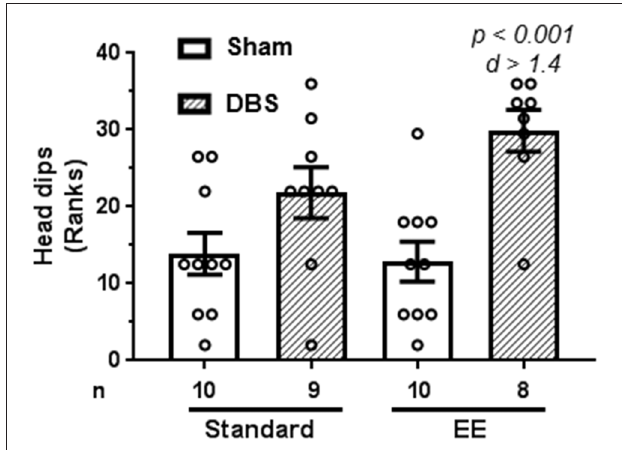
FIGURE 3 | Effects of DBS on risk assessment in an elevated plus-maze in presence or absence of EE. Risk assessment was measured as number of head dips made during the trial. This endpoint was rank-transformed for the illustration. Mean and SEM, along with individual rank of animals in each group, are depicted. Number of animals ( n ) is also presented. Both p and Cohen’s d values are shown for statistically significant comparisons between DBS and corresponding sham groups.